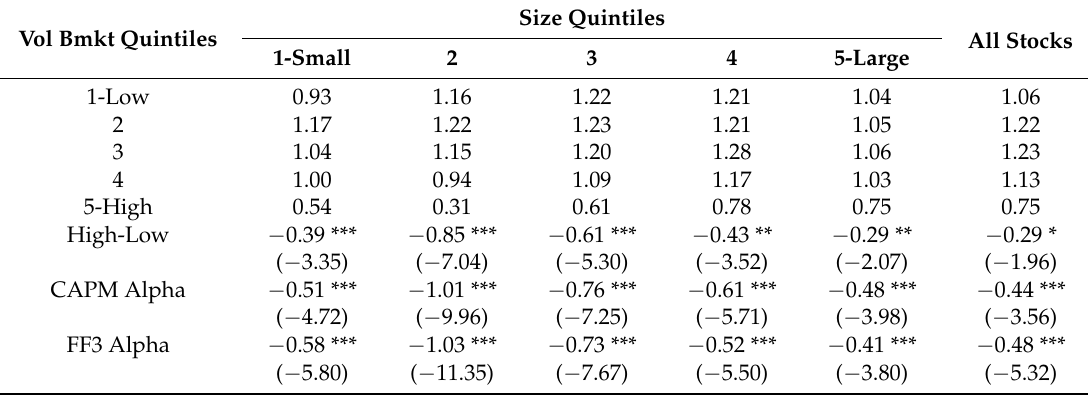
Table 3. Sort by Size and Vol_Bmkt.